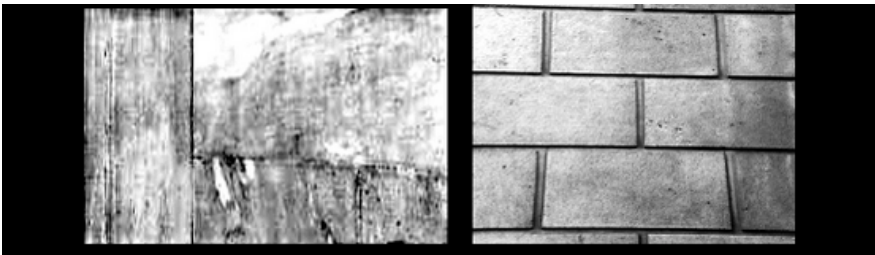
Figure 16. White Pentelic marble surface ( left ) and Kapandriti’s stone surface ( right ) at the historic Bank of Greece building in Athens.